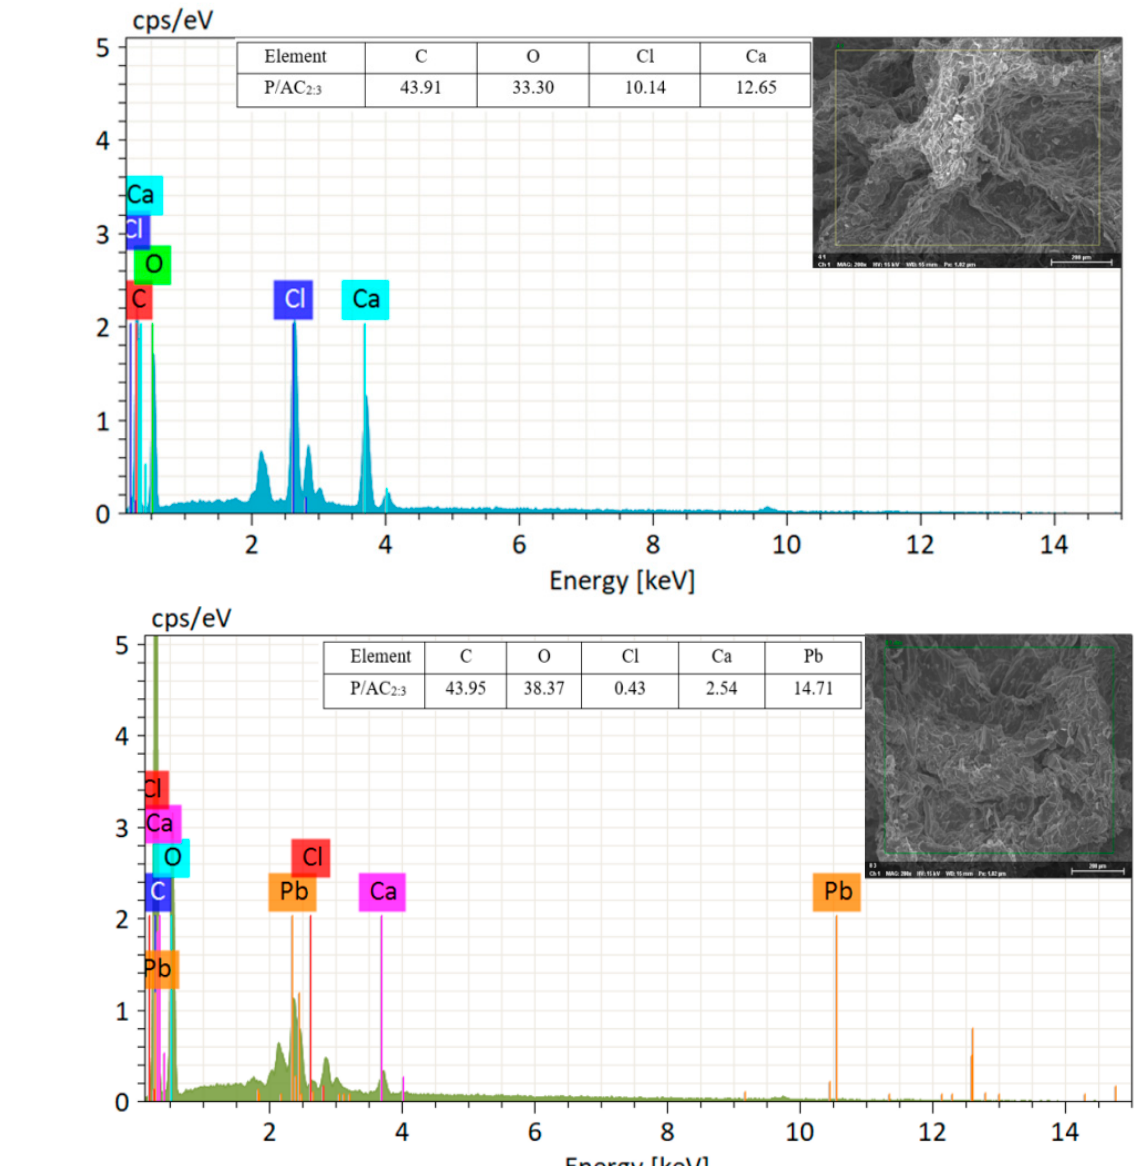
Figure 8. EDX image of P/AC 2:3 before ( A ) and after ( B ) Pb 2+ adsorption.